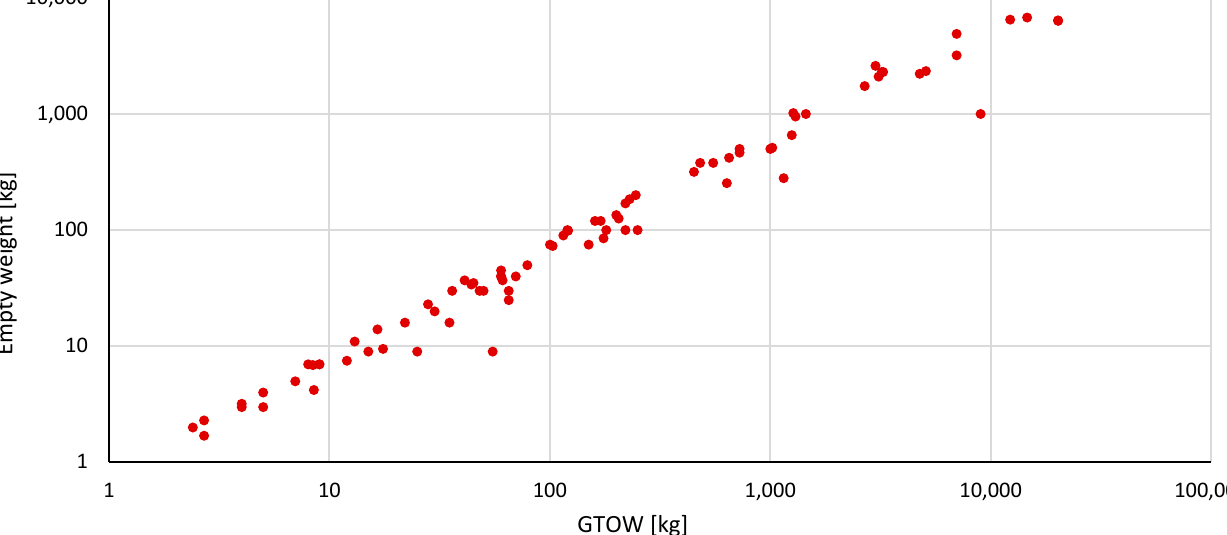
Figure 12. Empty weight as a function of GTOW with respect to NATO classi fi cation. The color code is identical to the one described in Figure 6. Table 7. Statistical data regarding the trend fi tt ing for the empty weight as a function of GTOW plots. R 2